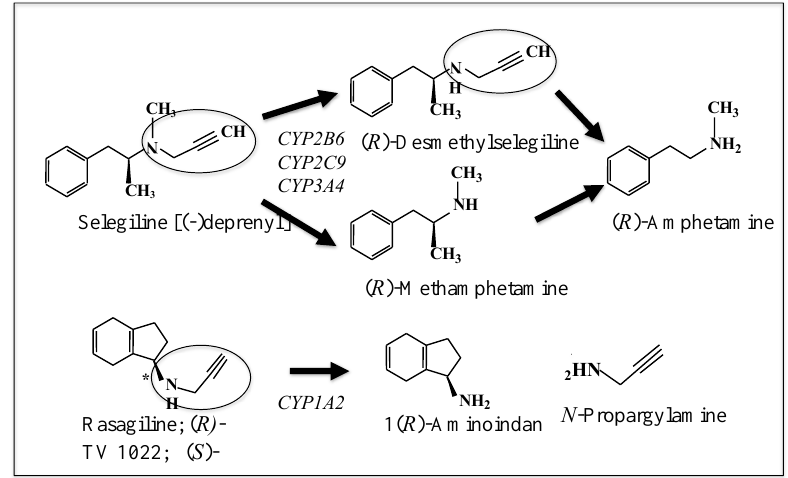
Figure 2. Chemical structure of selegiline and rasagiline and their metabolites. Aminoindan, a metabolite of rasagiline, has neuroprotective function, in contrast to ( R )-methamphetamine produced from selegiline.